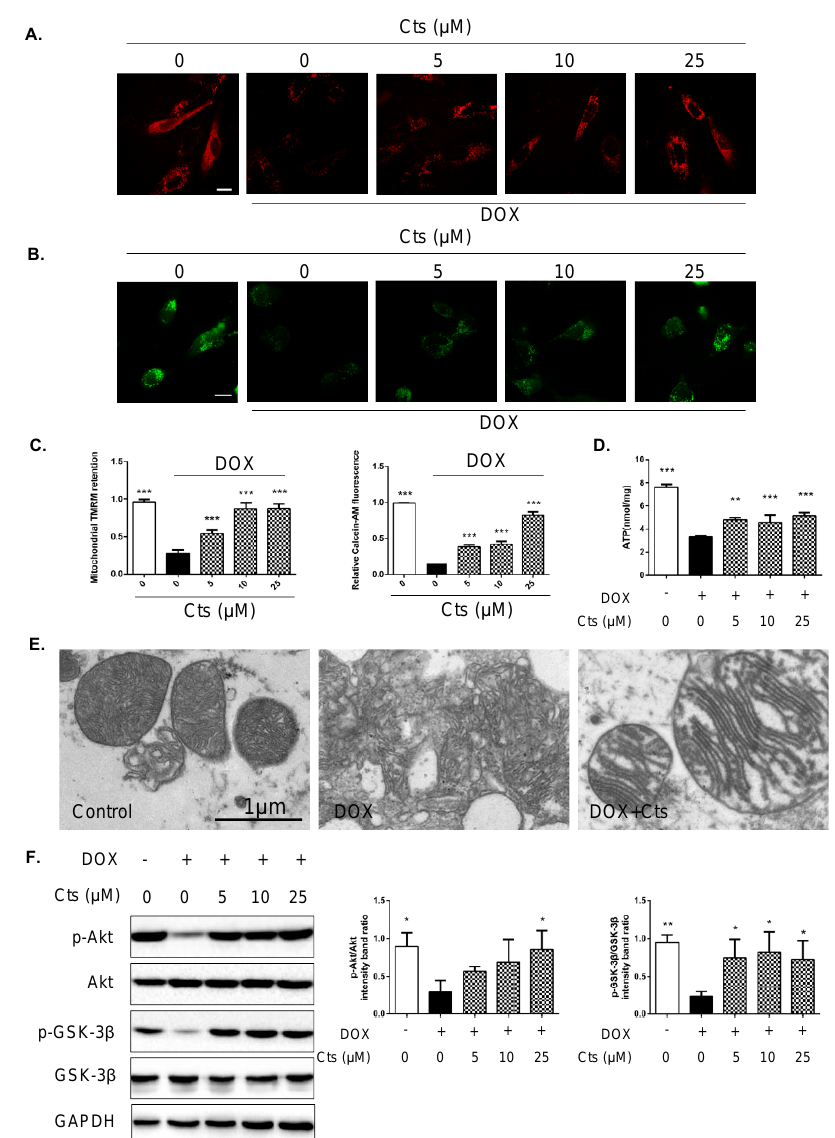
Figure 3. Effects of Cts on mitochondrial membrane integrity and phosphorylation of Akt and GSK- 3 β . Fluorescence images of tetramethylrhodamine methyl ester perchlorate (TMRM) sequestration ( A ) and calcein sequestration ( B ) in mitochondria. Scale bar, 50 µ m. ( C ) Quantification of TMRM sequestration and calcein sequestration in mitochondria. Fluorescence intensity was determined by image J software. Results were presented as means ± SD ( n = 3 repeated experiments, 15 cells per group). *** p < 0.001 vs. Dox-treatment group. ( D ) Dox decreased ATP production. Cts at different concentrations significantly increased ATP levels. Results were presented as means ± SD ( n = 6 per group). ** p < 0.01, *** p < 0.001 vs. Dox-treatment group. ( E ) Electron microscopy was used to compare mitochondrial morphology in cardiomyocytes from different groups. ( F ) Western blot showed that the levels of p-AKT and p-GSK-3 β were significantly increased in the Cts-treatment group compared with the Dox-treatment group. Results were presented as means ± SD from independent experiments performed in triplicate. * p < 0.05 vs. Dox-treatment group.